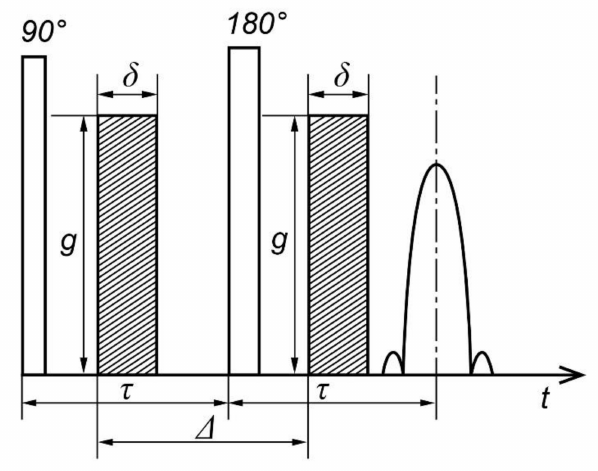
Figure 2. Two-pulse Hahn method with a pulsed magnetic field gradient (PGSE—pulse gradient spin-echo).